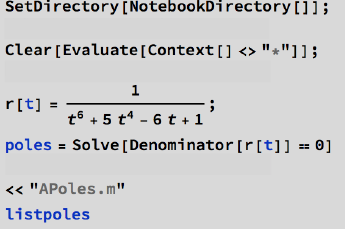
Figure 44. Part of the structure that allows us to compute and locate poles of r